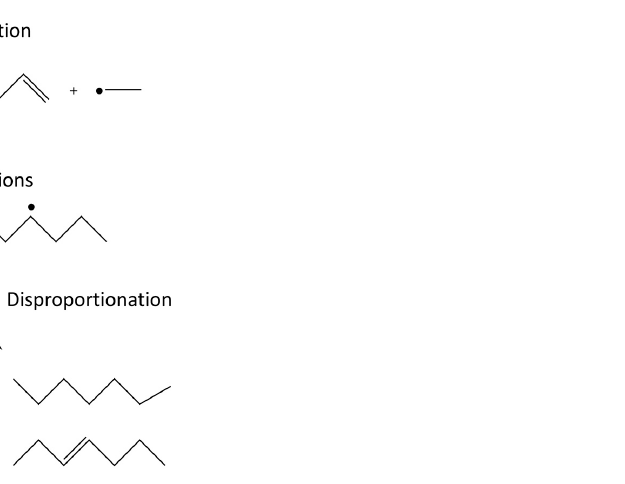
Figure 1. Unimolecular and bimolecular reactions occurring in irradiated polymers. The unimolecular reaction is scission (depolymerization) and the bimolecular reactions are radical-radical combination and disproportionation.